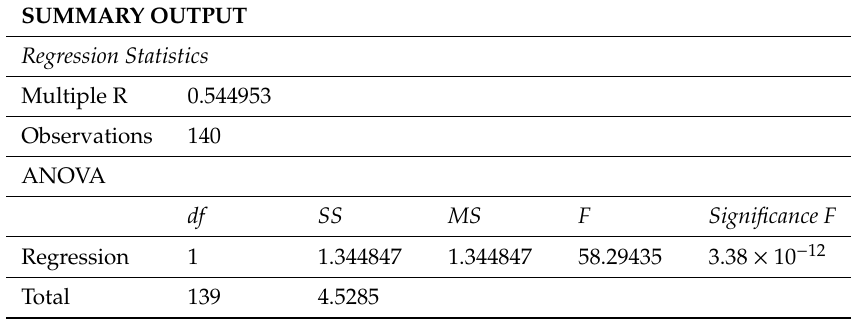
Table 4. Correlation—% share of public sector representation and utilization of Community planning of social services